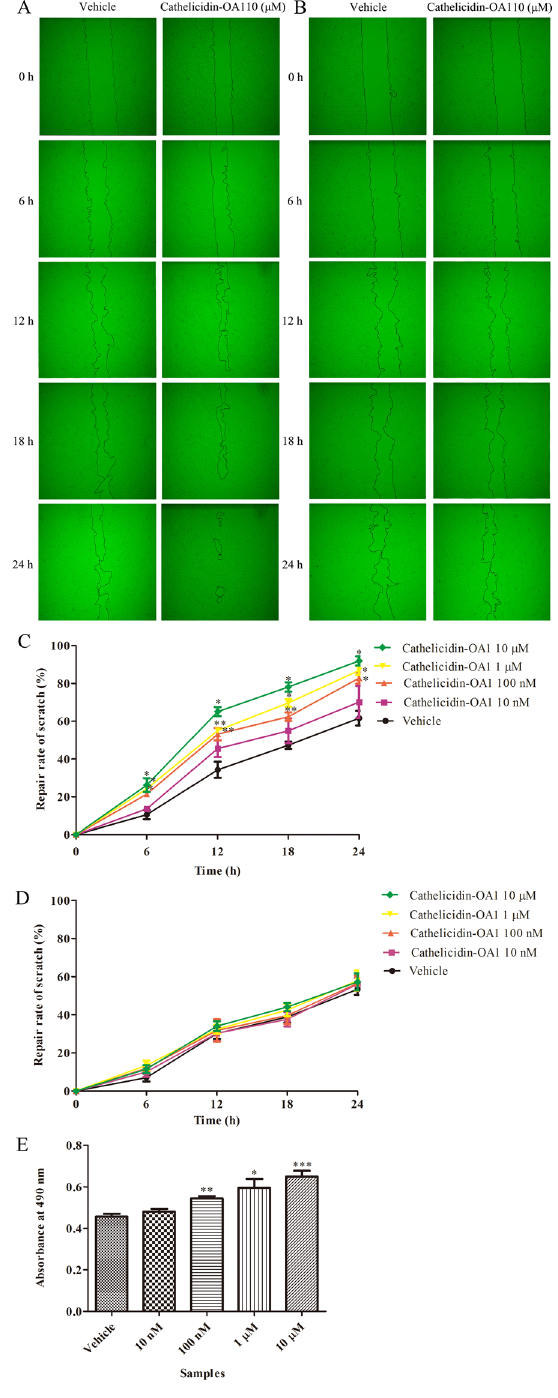
Figure 5. Effect of cathelicidin-OA1 on the repair rate of HaCaT cell wounds (scratches). ( A ) Cathelicidin-OA1 (10 μ M) illustrated obvious HaCaT cell wound-healing activity. ( B ) Cathelicidin-OA1 (10 μ M) illustrated no obvious HaCaT cell wound-healing activity when proliferation was inhibited by mitomycin C. ( C ) Cathelicidin-OA1 illustrated time- and dose-dependent HaCaT cell wound-healing activity. ( D ) Cathelicidin-OA1 illustrated no time- or dose-dependent HaCaT cell wound-healing activity when proliferation was inhibited by mitomycin C. ( E ) At concentrations of 10 nM to 10 μ M, cathelicidin-OA1 showed proliferative effects on HaCaT cells. ‘Vehicle’ is the negative control; * P < 0.05 and ** P < 0.01 indicated significantly different from the vehicle (Student’s t- test). Data are mean values of three independent experiments performed in